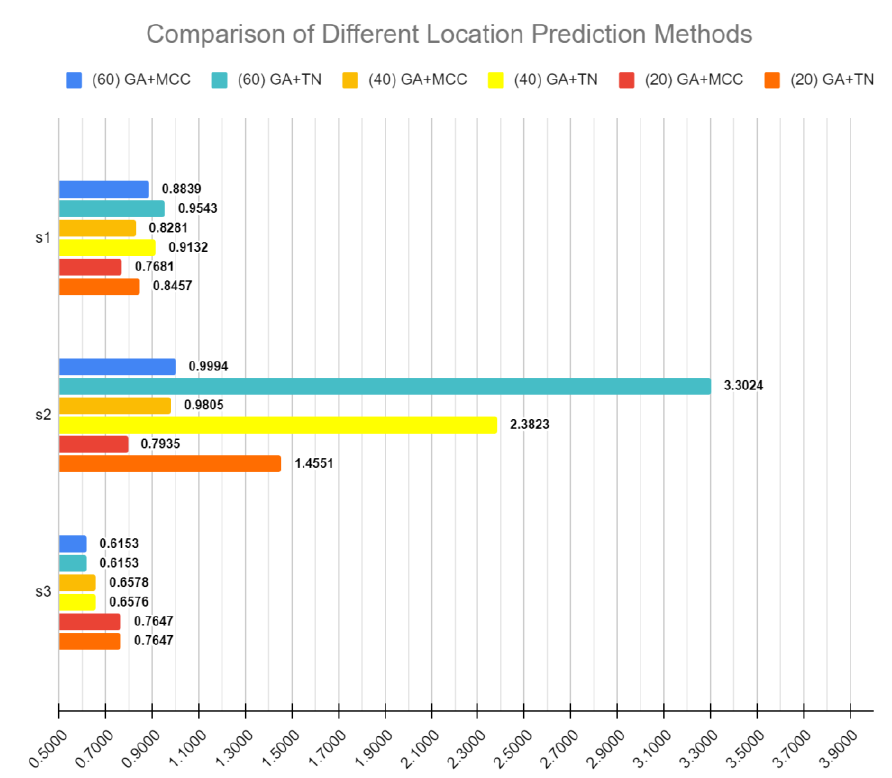
Figure 3. Barplot showing comparison of three DREAM sub-challenge score (s1, s2 and s3), using a different location prediction method, on gene sets generated by GA feature-selection algorithm. GA + Mathews correlation coefficient (MCC) and GA + Thin Nguyen (TN). TN is the location prediction method used by top-performing team in Sub-Challenge1 (Thin Nguyen). Scores generated after bootstrapping 1000 times and definitions are as provided by DREAM Single Cell Transcriptomics Challenge.